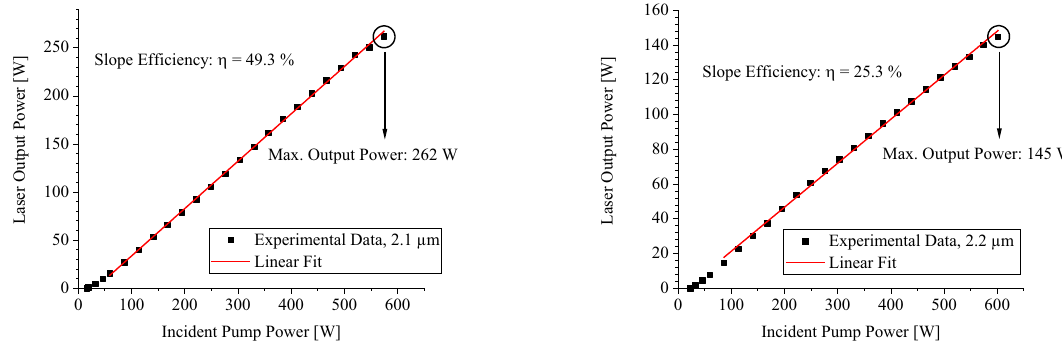
Figure 1: Laser output power versus incident 79X nm pump power of the Tm 3+ :Ho 3+ -codoped fiber laser at an emission wavelength of 2.1 µm (left-hand side) and at an emission wavelength of 2.2 µm (right-hand